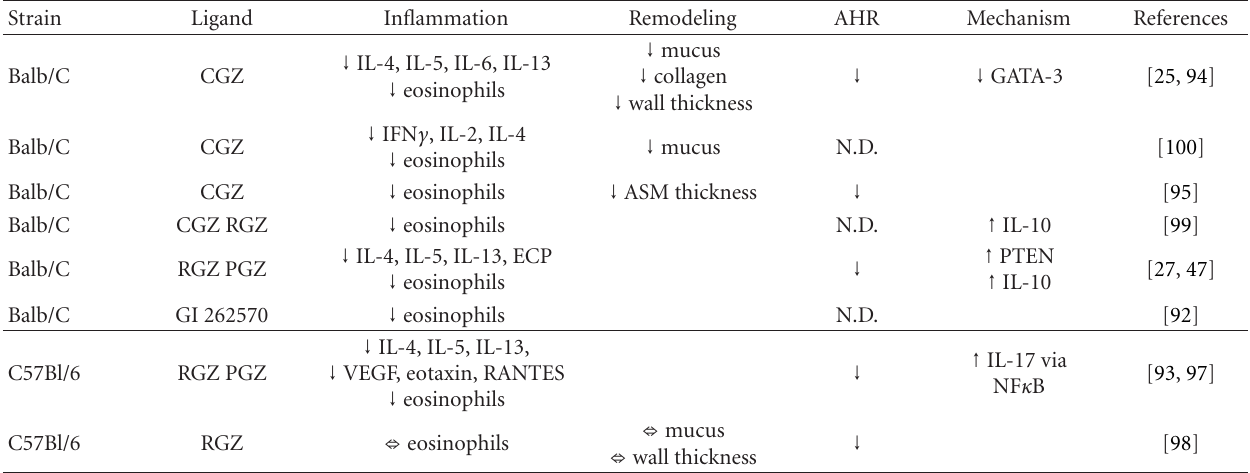
Table 1: E ff ects of PPAR γ ligands in mouse OVA models of allergic airways